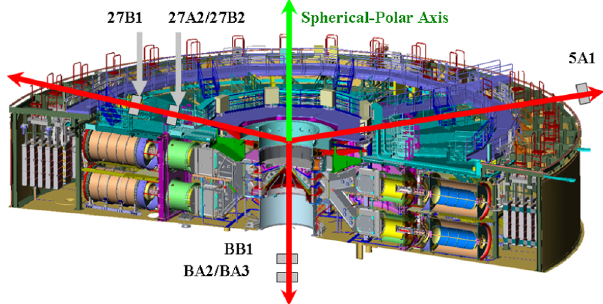
FIG. 1. Perspective view of the Z accelerator for MagLIF target experiments and of the lines of sight used for nTOF measure- ments (not to scale). Depicted inwards from the outer oil-tank wall are Marx generators, storage capacitors, pulse-forming lines, and the insulator stack; not shown is the MagLIF target-chamber insert itself. Labeled NTOF detector locations are shown on the various diverging lines of sight and correspond to Table I. The origin of the spherical-polar coordinate system coincides with the target, and its polar axis (green) is coincident with the cylindrical symmetry axis of the target